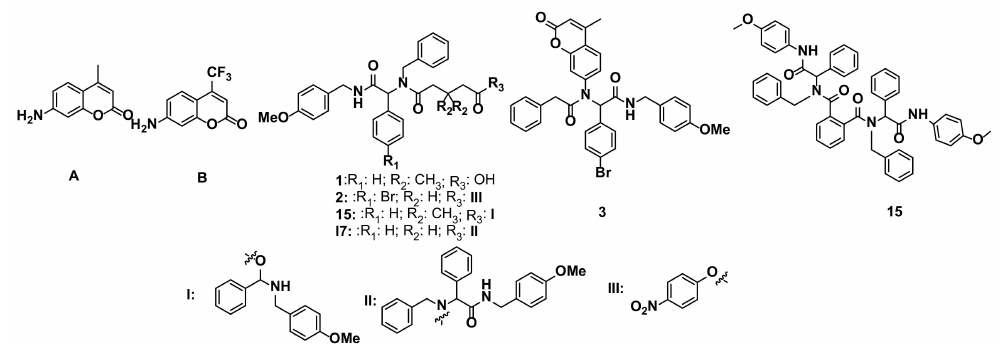
Figure 1. Structure of model compounds used in the